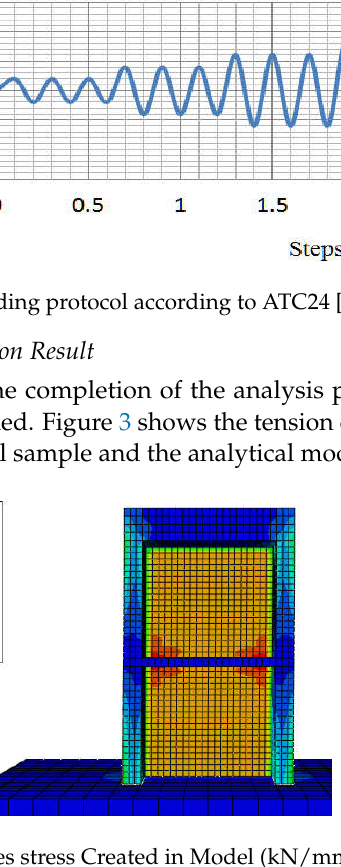
Figure 1. The meshed state of the damper in 3D mode.